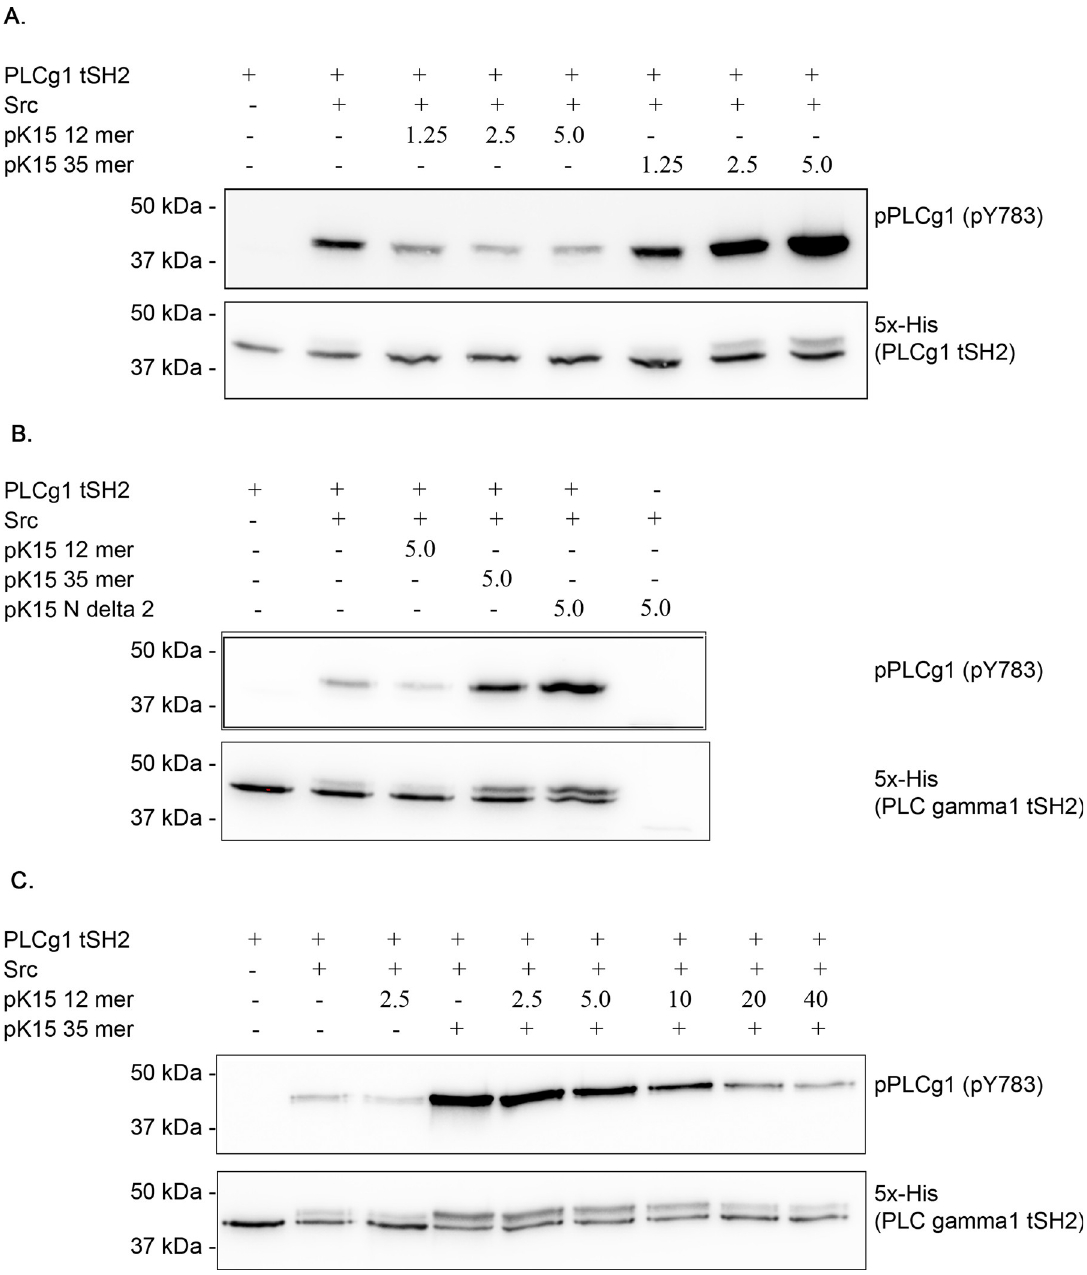
Fig 7. The pK15 CT domain enhances Src-mediated phosphorylation of the PLC γ 1 tSH2 domain. (A) The purified PLC γ 1 tSH2 domain (0.6 μ M) was incubated with limiting amounts (0.085 μ M) of recombinant purified Src kinase expressed in insect cells in the presence of increasing concentrations (1.25–5 μ M) of phosphorylated peptides representing the last 12 (pK15 12mer) or 35 (pK15 35mer) amino acids of the pK15 cytoplasmic domain for 1 hour at 37˚C. The reaction was stopped using SDS sample buffer and analysed by SDS-PAGE and Western blot using an antibody to the PLC γ 1 pY 783 residue (top panel) or to the His tag on the recombinant tSH2 domain (bottom panel). (B) Same as above, except that a fixed concentration (5.0 μ M) of the 12mer peptide, the 35mer peptide or the pK15 truncation construct GST-pK15 CT N2 [51] were used. The increased phosphorylation of the tSH2 domain in the presence of the 35mer peptide and pK15 CT N2 can be seen. (C) Increasing concentrations of the phosphorylated pK15 12mer peptide were used to inhibit the increased src-mediated phosphorylation of tSH2 induced by 2.5 μ M of the pK15 35mer peptide. Experimental conditions were as in panel A.